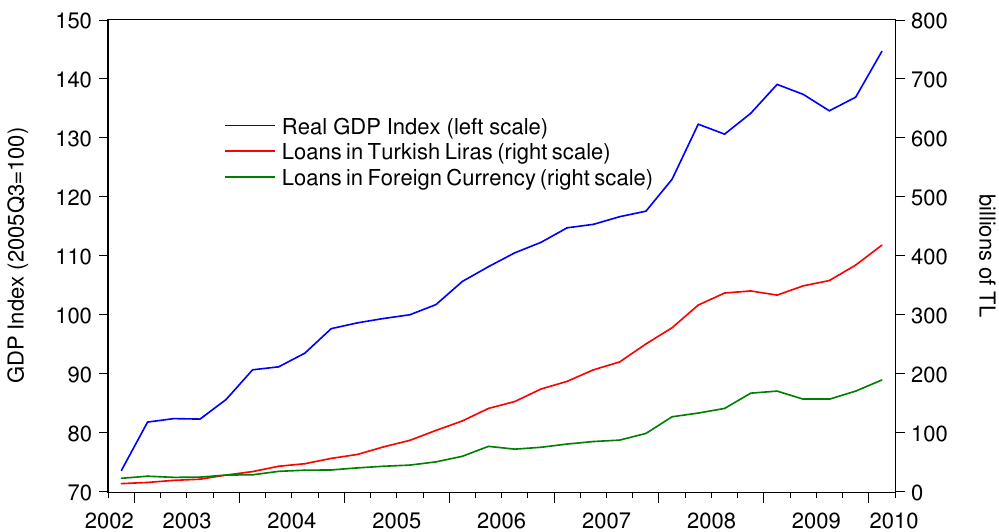
Figure 6. GDP vs. Loans in TL and Foreign